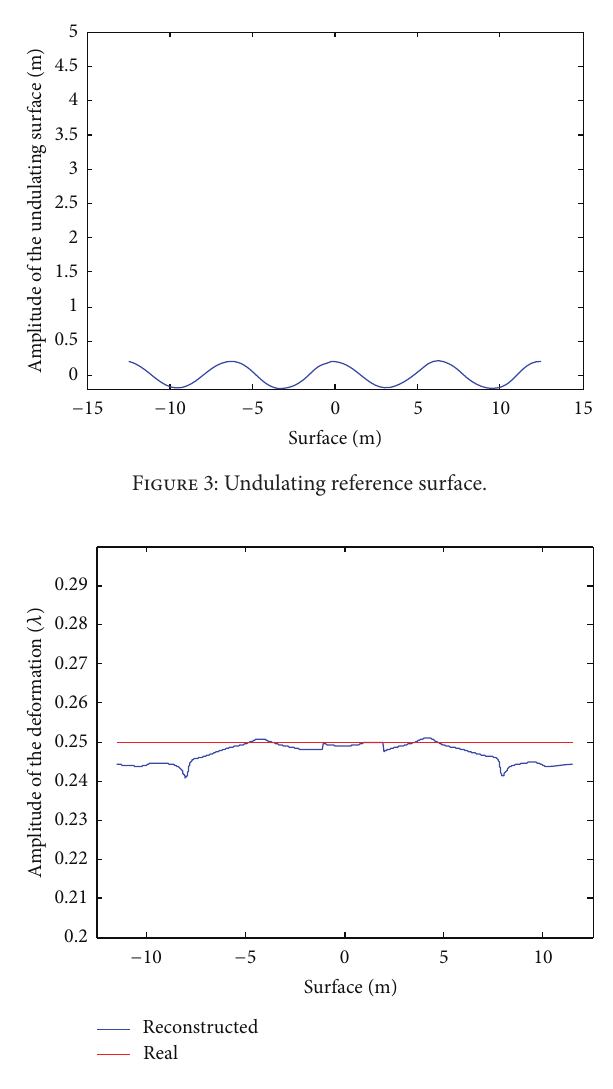
Figure 4: Surface deformation reconstructed (blue line), real surface deformation (red line).